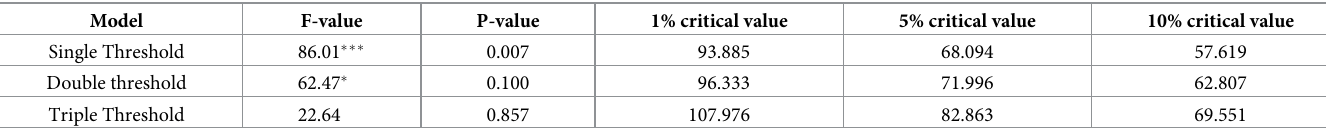
Table 5. Threshold effect test.